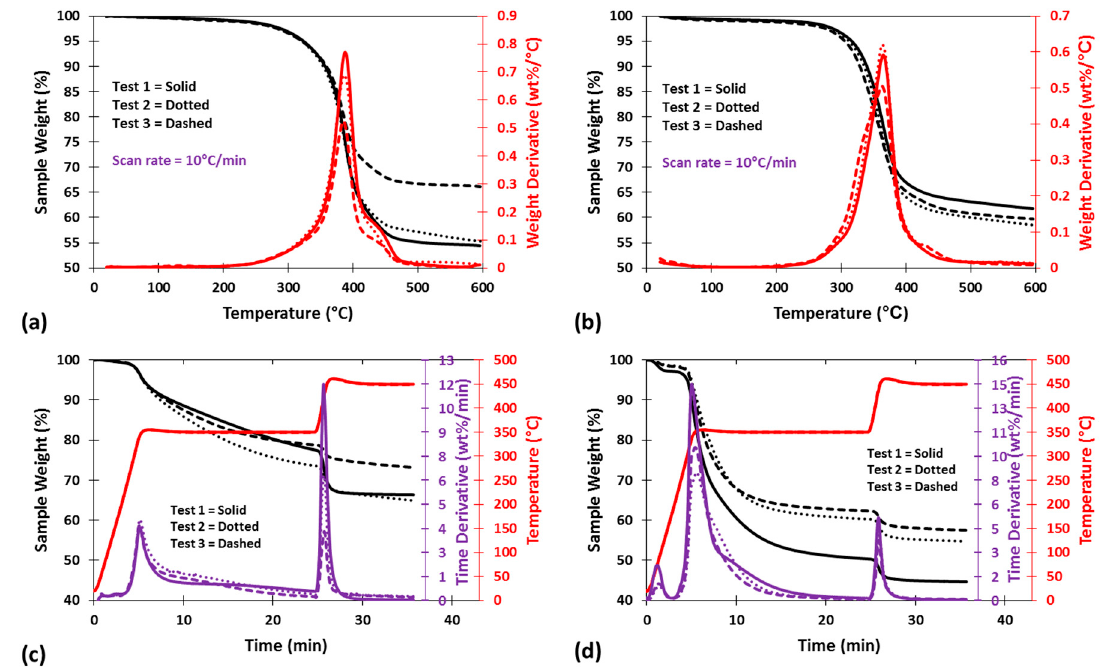
Figure 2. Respective TGA results for each of the tested composite waste materials. Three samples scanned at a rate of 10 °C/min for each test material: ( a ) SMC, ( b ) wind blade. Three samples during a simulated two temperature step pyrolysis procedure: ( c ) SMC, ( d ) wind blade. Data suggests a generic thermal profile capable of being used in large scale pyrolysis recycling